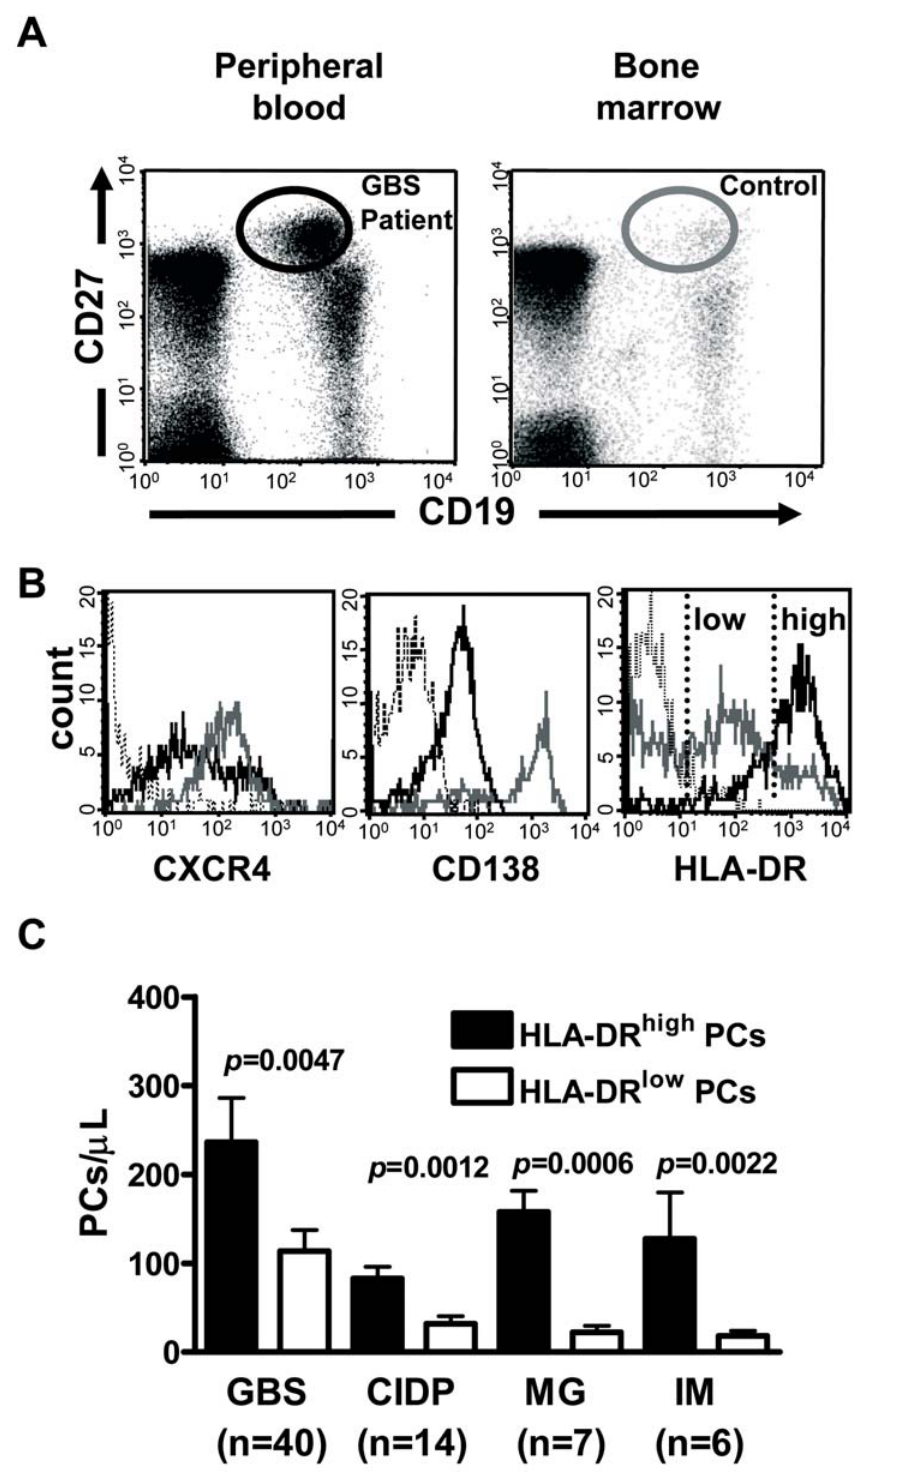
Figure 3. Most IVIg-mobilized CD19 + CD27 high cells are immature. (A) Representative analyses of circulating and bone marrow CD19 + CD27 high cells in a GBS patient 7 days after IVIg infusion and in a healthy bone marrow donor. (B) Control mature medullary CD19 + CD27 high plasma cells (as identified in panel A, right) were CXCR4 high CD138 high HLA-DR low (gray line). Circulating IVIg-mobilized CD19 + CD27 high plasma cells were CXCR4 low CD138 low HLA-DR high (solid line). Isotype controls were presented (dotted line). (C) Balance between immature (HLA-DR high ) and mature (HLA-DR low ) plasma cells (PCs) in IVIg-treated patients 7 days after treatment. GBS (disability grade 3 or more, n=40) and CIDP (n=14) patients received IVIg only, whereas MG (n=7) and IM (n=6) patients received IVIg and steroids. Data are mean 6 s.e.m. Comparisons of indicated mean values were performed by use of Mann-Whitney U test.